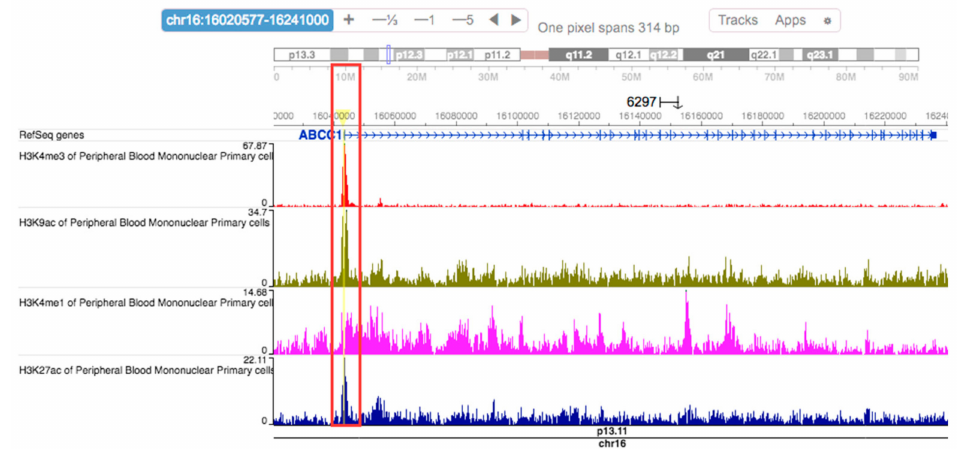
Figure 4. WashU Epigenome Browser schematic of histone marks enriched at the ABCC1 promoter SNP rs504348. Peaks at H3K4me3, H3K9ac, H3K4me1, and H3K27ac (highlighted in red box)